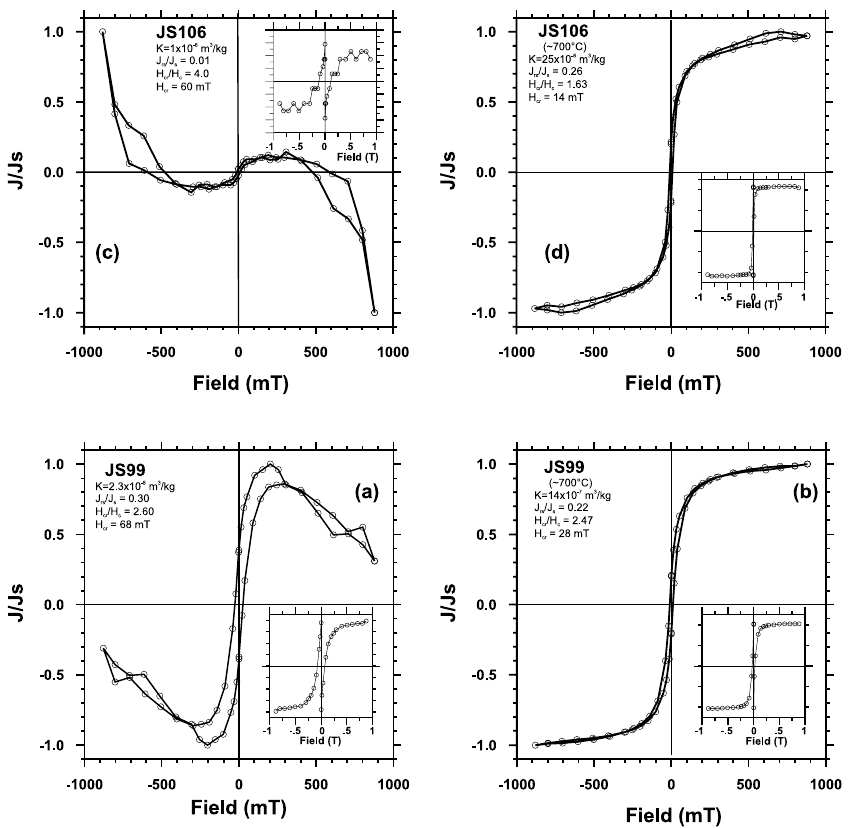
Fig. 6 – Characteristic hysteresis curves for the Botucatu samples acquired in a Molspin Ltd. VSM equipment before (6a and 6c) and after (6b and 6d) heating samples up to 700 ◦ C. Insets show acquisition of isothermal remanent magnetization, and back-field remanent